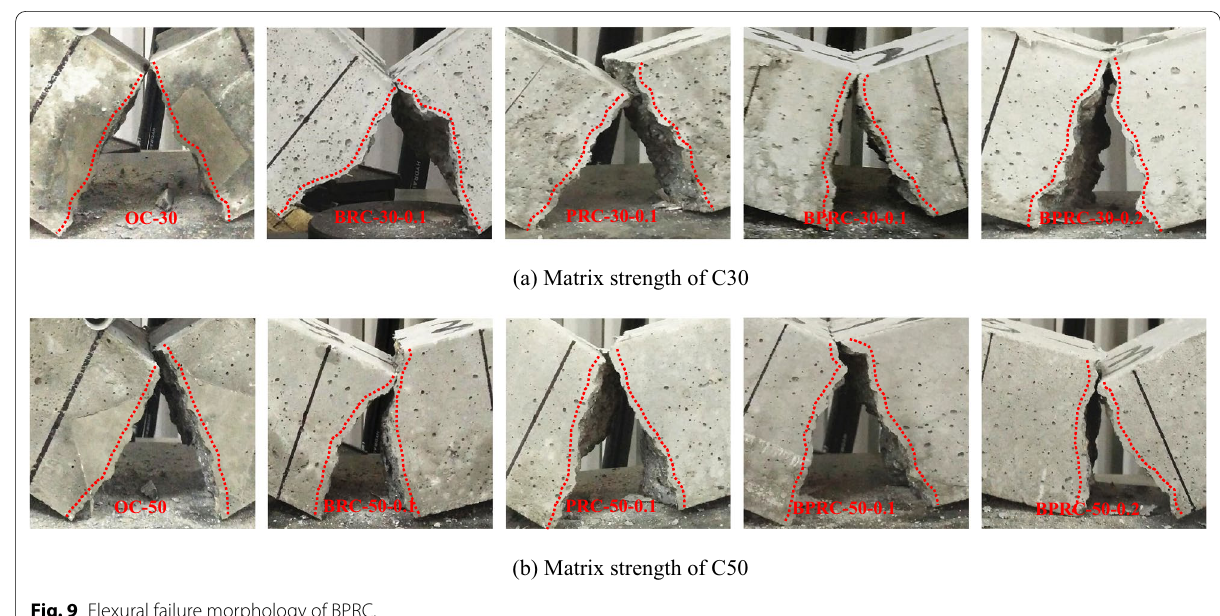
Fig. 9 Flexural failure morphology of